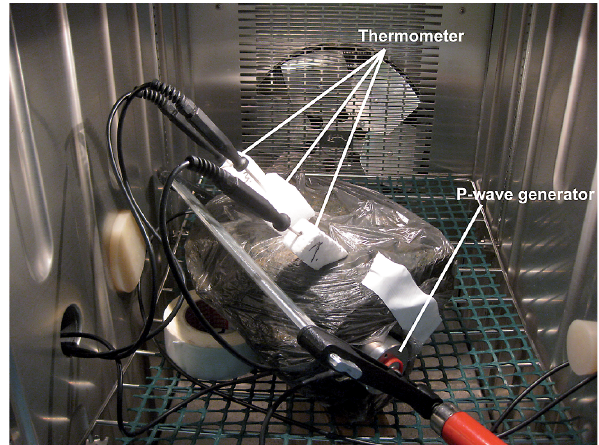
Fig. 1. Laboratory measurement set up of a p-wave velocity mea- surement of a schisty quartz slate sample (S1) in parallel direction to cleavage. Drilled into the rock sample are three thermometers to monitor rock